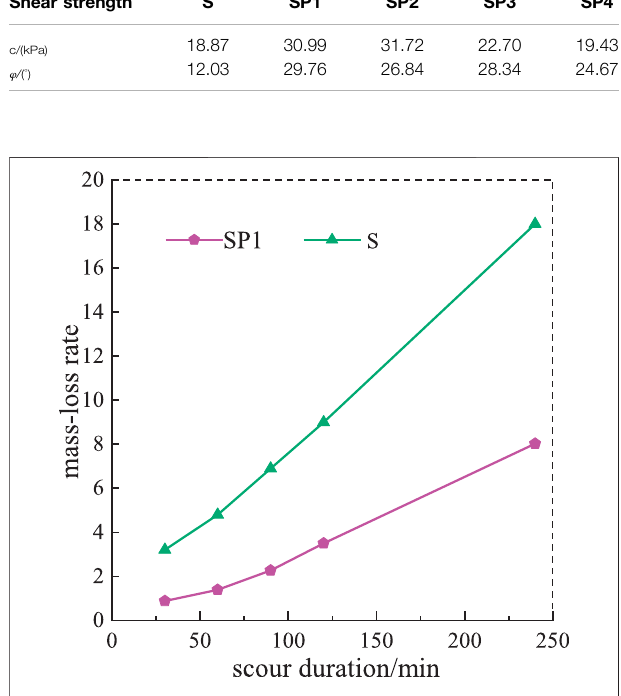
FIGURE 6 | Relationship between mass-loss rate and erosion duration